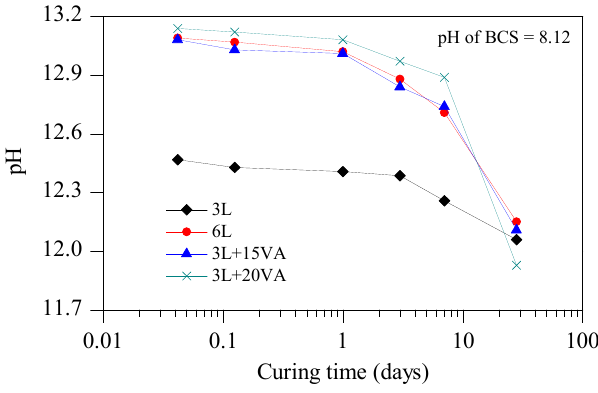
Figure 6. Variation of pH in stabilized BCS with curing time.